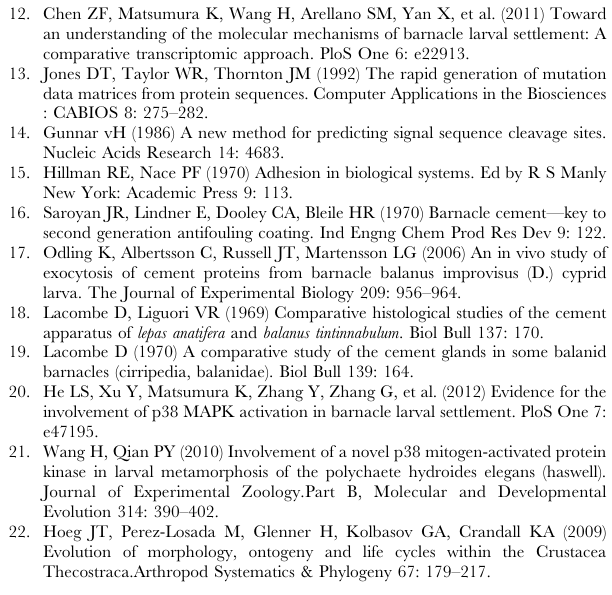
Figure S1 The full patterns of Western Blots against Bamcp20k-1 and Bamcp20k-2. Cyprids and adults were extracted in PBS buffer and then subjected to the SDS-PAGE